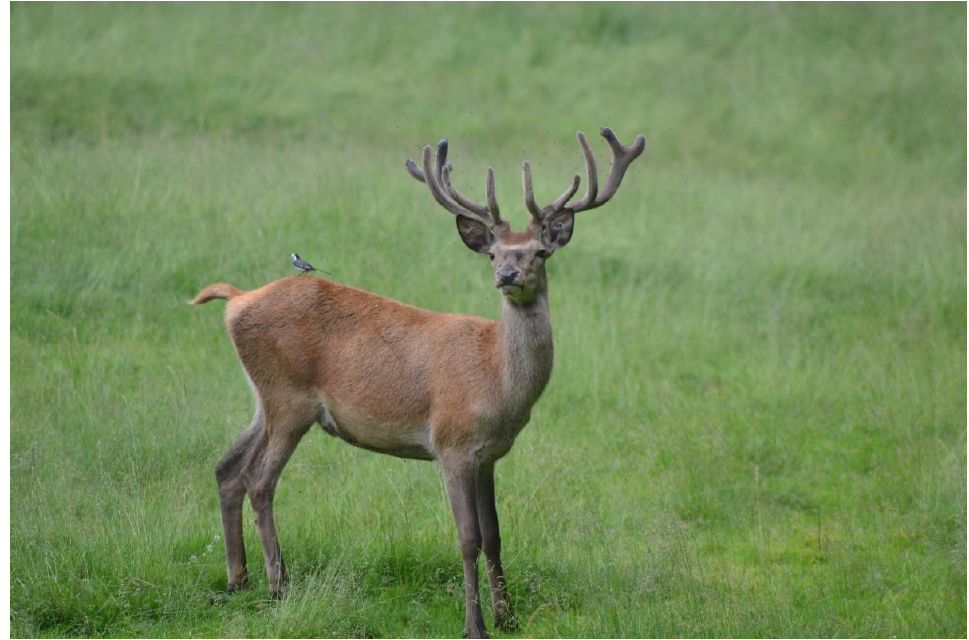
Figure 4. Alarmed subordinate male. The neck is prominent and the head is held high; the ears are directed toward the source of disturbance.